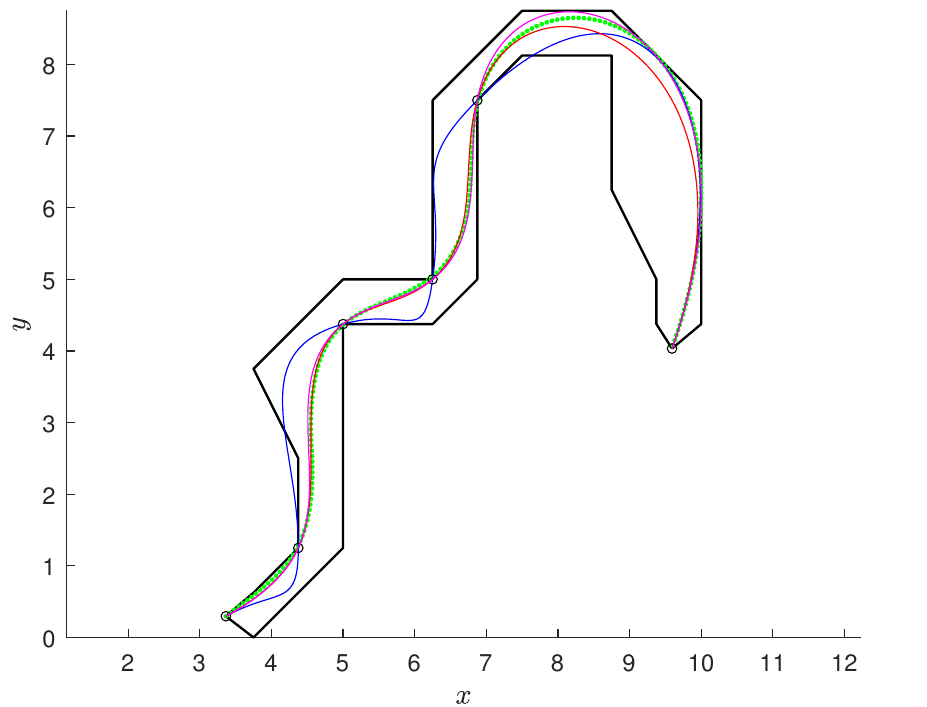
Figure 7. The paths constructed to be contained in the black polygon in Example 2: funnel algorithm [40] (green line), Algorithm 1 with free parameters obtained by the algorithms in Sections 3.1 and 3.2 (blue), by optimization (magenta), and by copying free parameters from the funnel algorithm [40] (red).